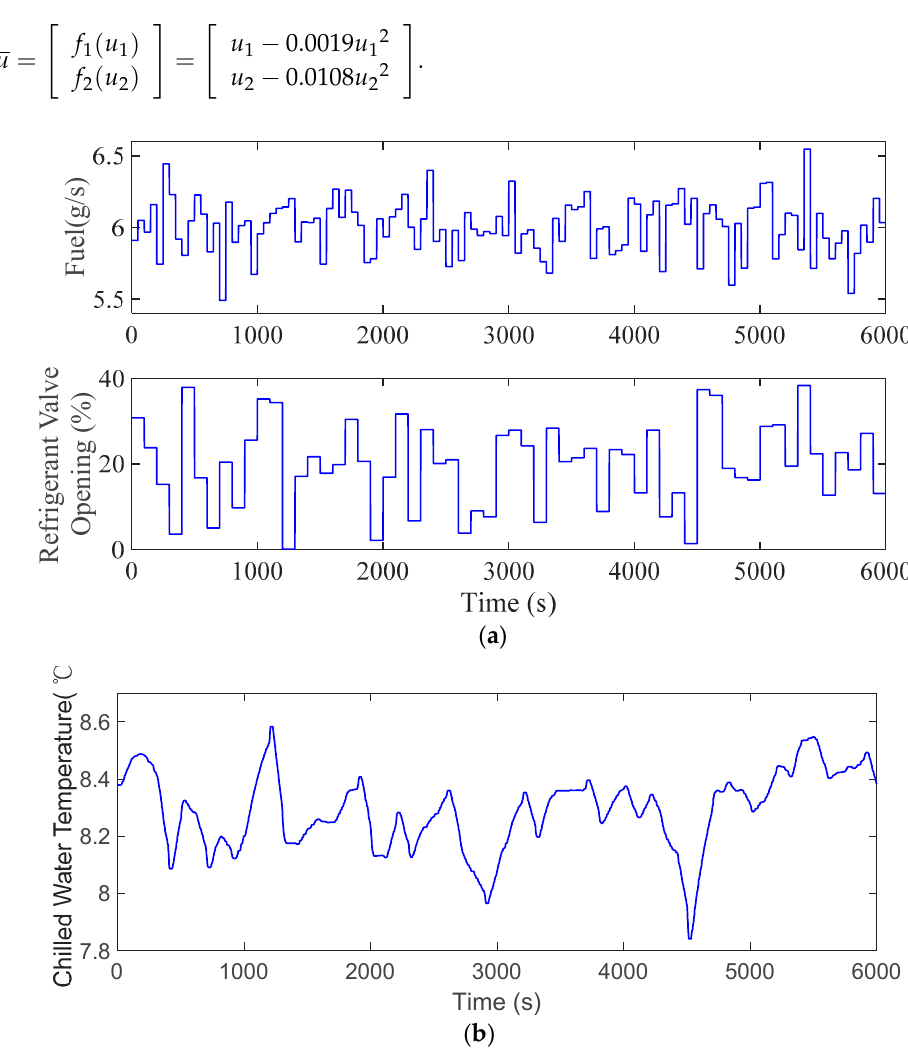
Figure 8. Identification data (cooling system). ( a ) input command data; ( b ) output data.